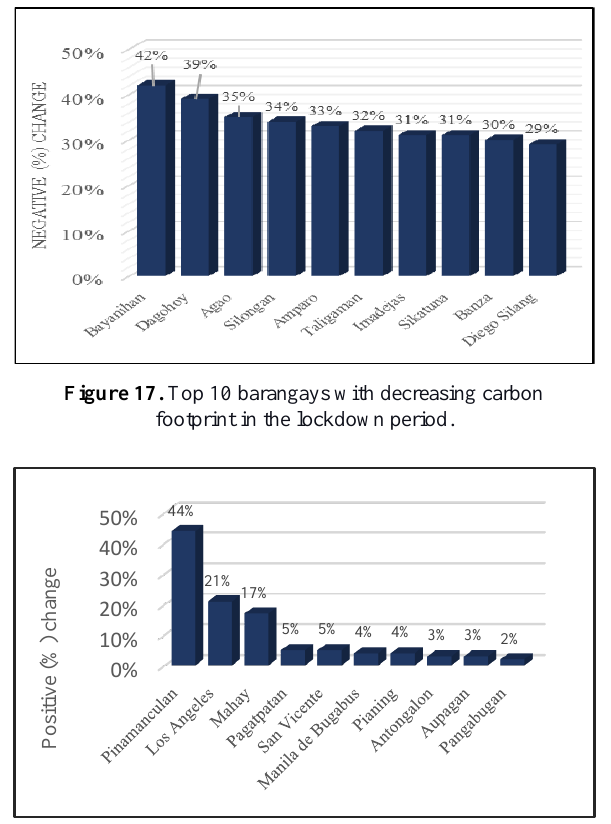
Figure 16. Carbon Footprint across 86 barangays in Butuan City during pre-lockdown vs. lockdown periods.